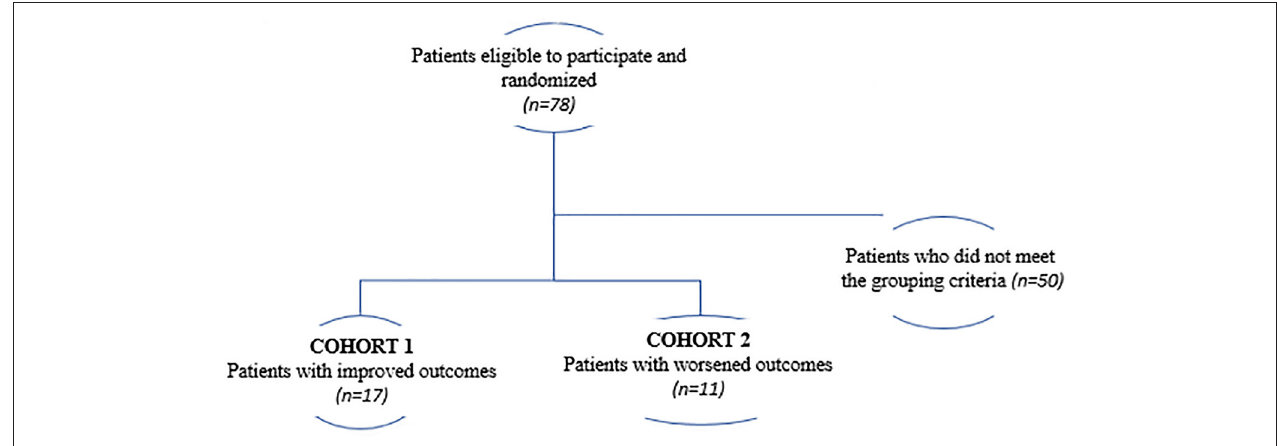
FIGURE 1 | Flowchart showing the grouping strategy used in this study.